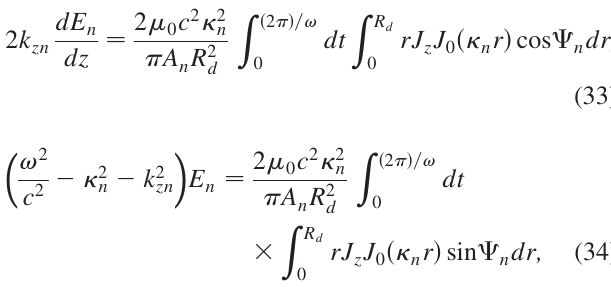
1 : 5 cm , and (cid:3) ¼ 4 . The electron beam has an energy of 340 keV and an injected beam current I ranges from 5 to b 500 A. Various scale lengths for the density inhomogeneity are chosen, ranging from (cid:1) ¼ (cid:4) 1 , to uniform ( (cid:1) ¼ 0 ), to (cid:1) ¼ 25 in Eq. (1). These parameters were chosen to pro- vide an operating frequency near 8 GHz for the TM 01 mode and 26 GHz for the TM 02 mode with spatial growth rates that are sufficiently large to saturate the instability within a 2 m length of the dielectric loaded waveguide. This set of parameters is fairly typical of experimental devices oper- ating in the microwave regime.